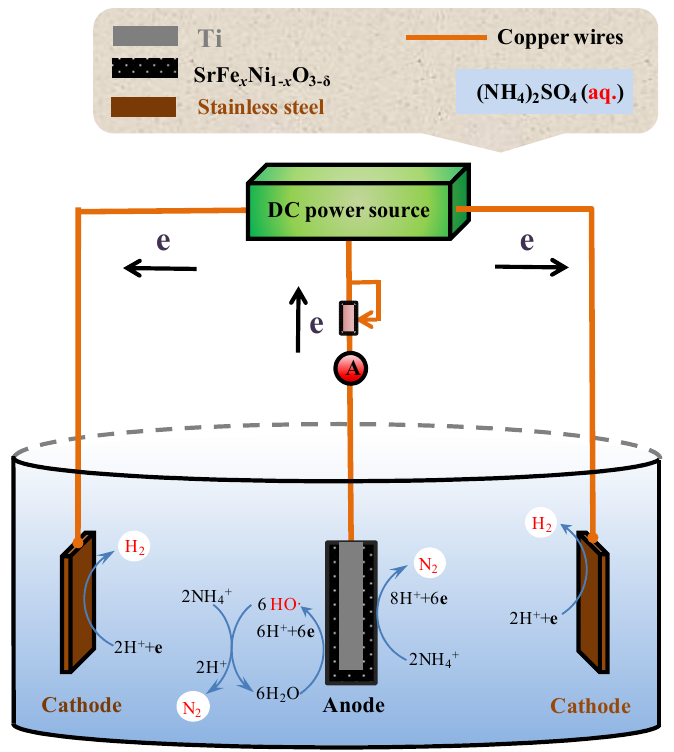
Figure 3. Schematic diagram of the electrocatalytic reactor (ECR).